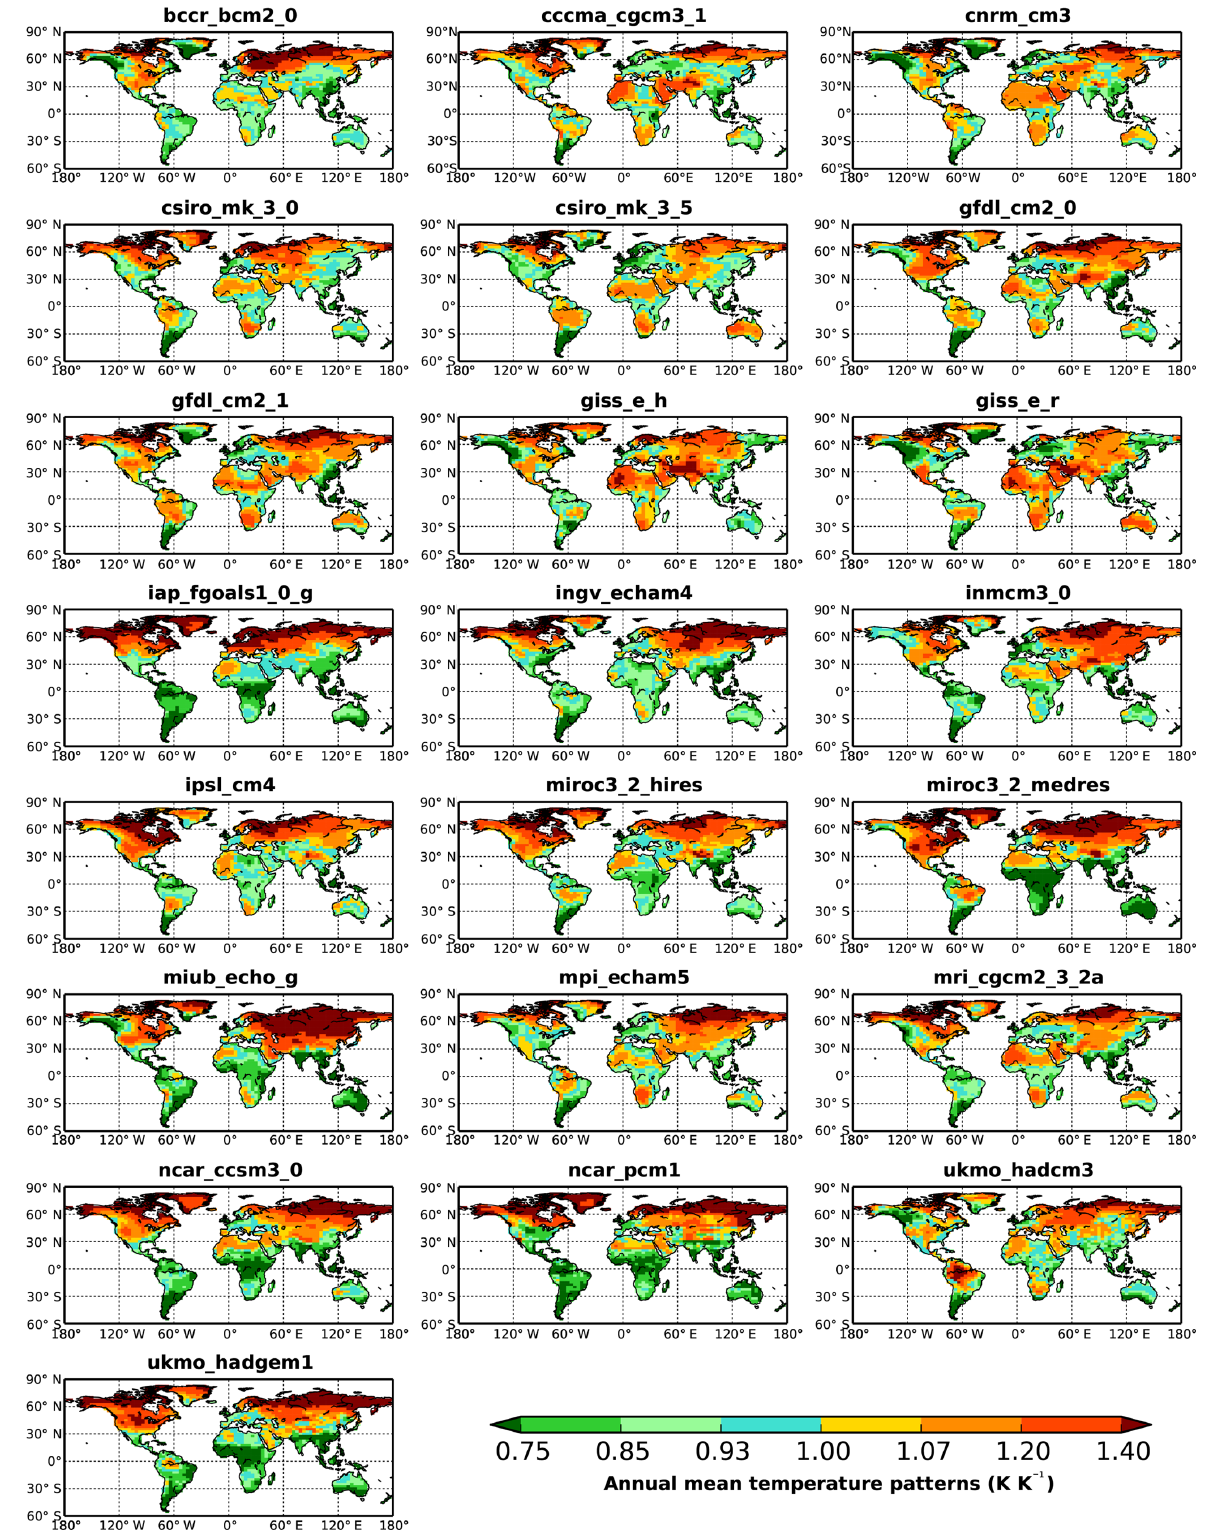
Figure 2. Annual means of the monthly patterns of local temperature change per degree warming over all land (KK − 1 ). Data presented for the 22 GCMs considered in this